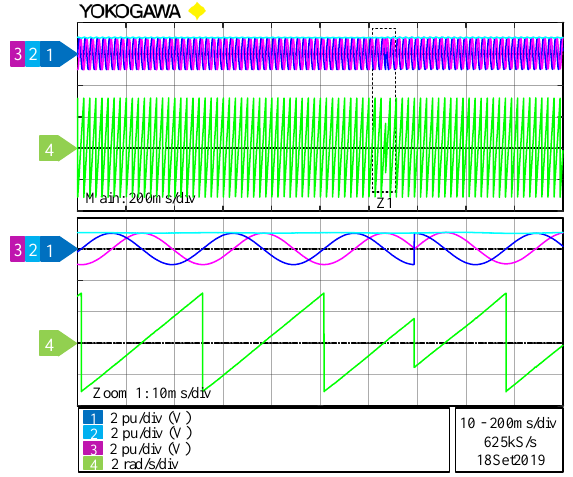
Figure 25. Experimental results related do Test 4—orthogonal signal generation and phase angle for a phase inversion.